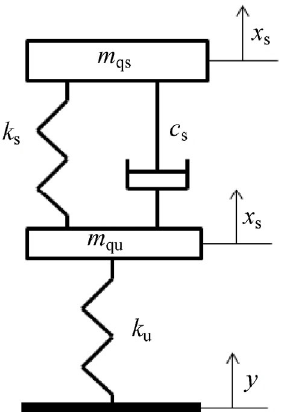
Fig. 9 Schematic of quarter car vehicle model.